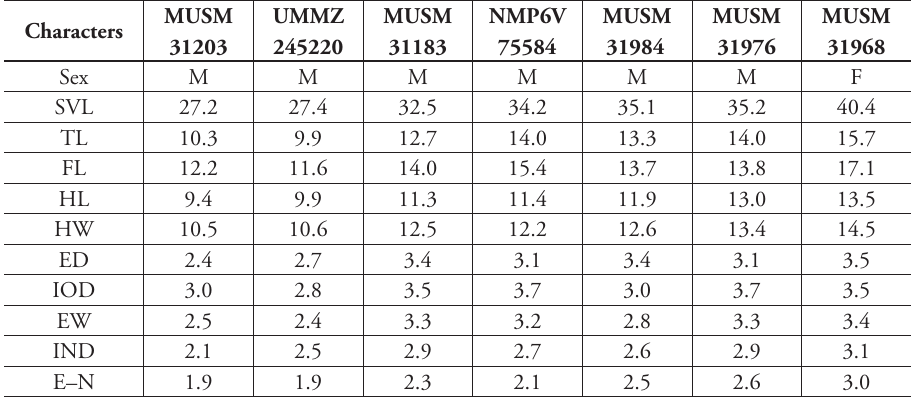
Table 3. Measurements (in mm) of adult type specimens of Phrynopus inti sp. n. M = male, F = female. For other abbreviations see materials and methods.